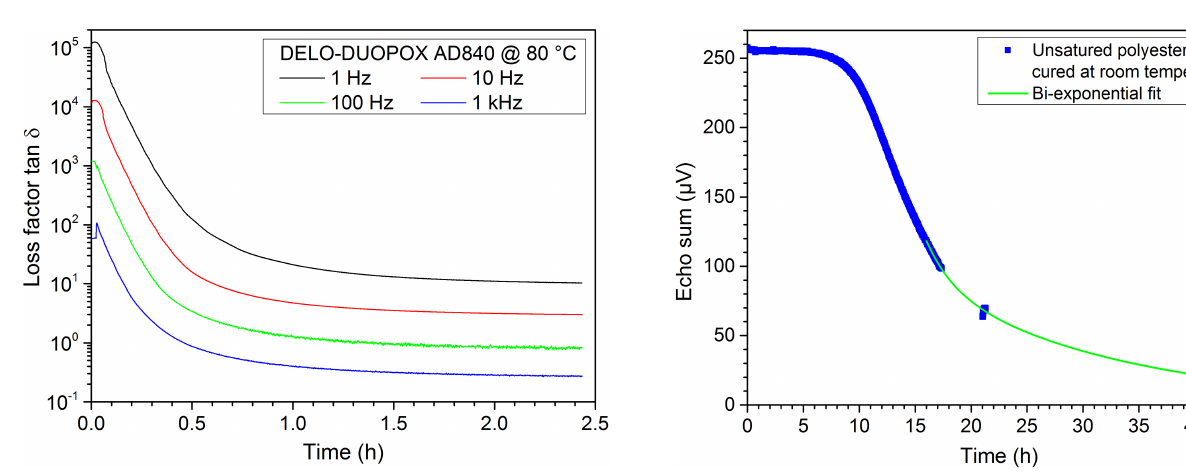
Figure 16. Curing of UP resin at room temperature: the expected bi-exponential decay has been verified by